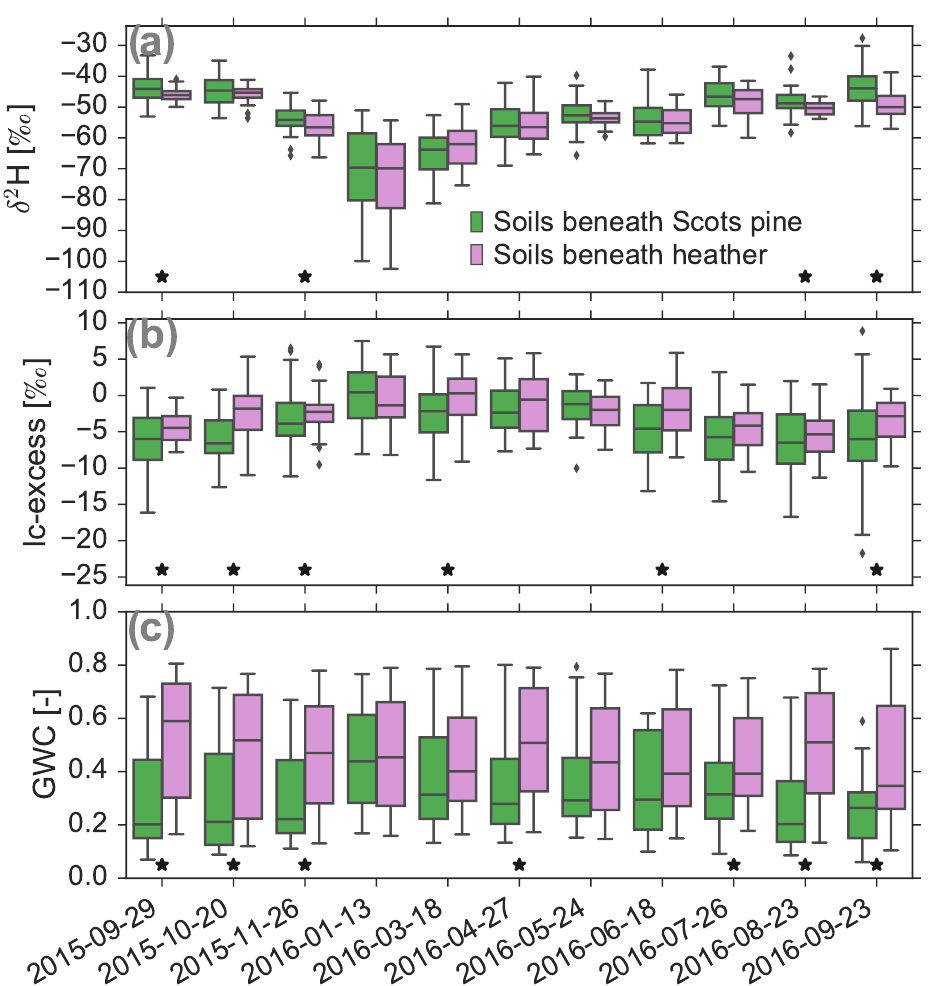
Figure 8. Differences of (a) δ 2 H, (b) lc-excess, and (c) gravimetric water content (GWC) for soils under Scots pine (green) and soils under heather (violet) during 1 year. Significant differences estimated with the Mann–Whitney–Wilcoxon test between soils under Scots pine and soils under heather for a particular day are indicated by a